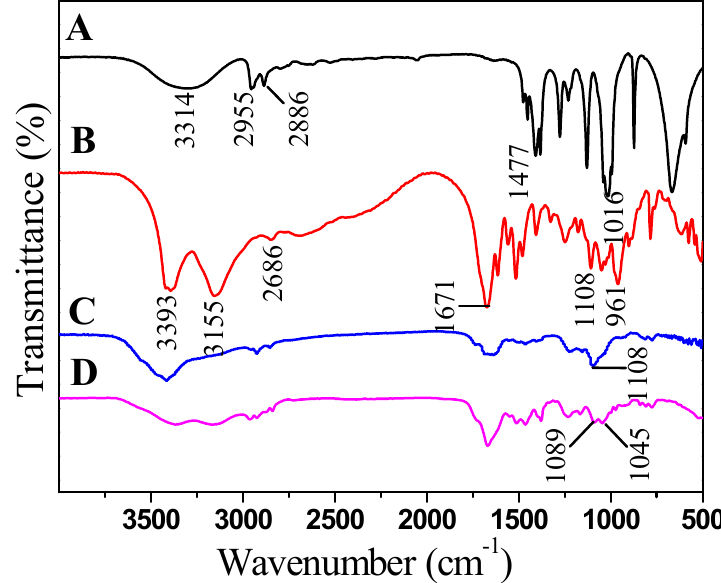
Figure 1 . FTIR spectra of (A) PER, (B) MP, (C) compound MP/PER/PP, and (D) reactive MP/PER/PP masterbatches.